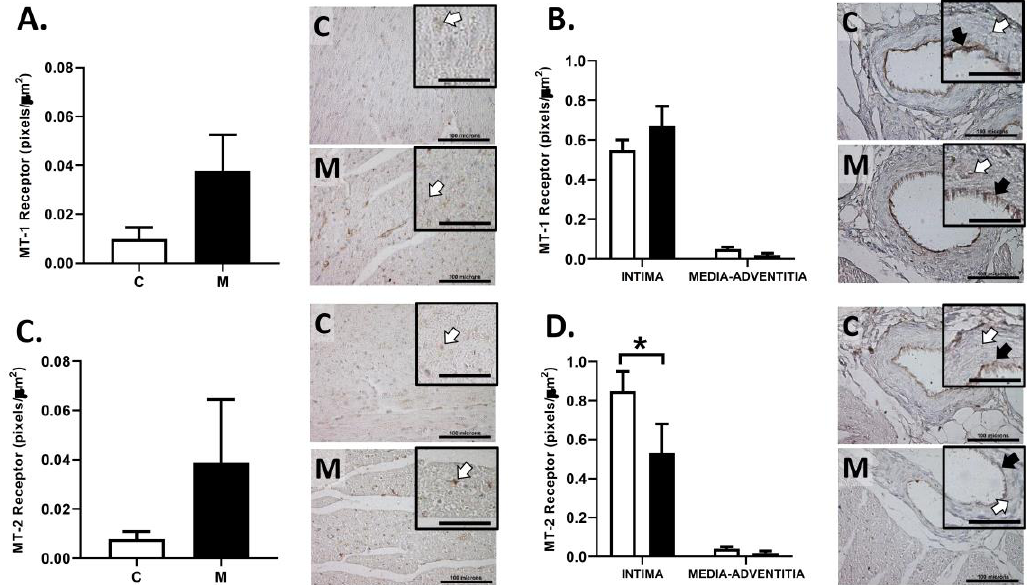
Figure 6. Melatonin receptors in right ventricle. Melatonin receptor immunostaining in right ventricle wall and endocardial arteries, for MT-1 ( A , B ) and MT-2 ( C , D ), in 29-day-old lambs. Groups are control (C, white bars) and melatonin treated (M, black bars). Representative micrographs are shown for each analysis with bar = 100 μm. Zoom box inside the micrograph with bar = 50 μm; white and black arrows show immunopositivity in muscle and endothelial areas, respectively. Data expressed as mean ± S.E.M. Significant differences ( p ≤ 0.05): * vs. CN.